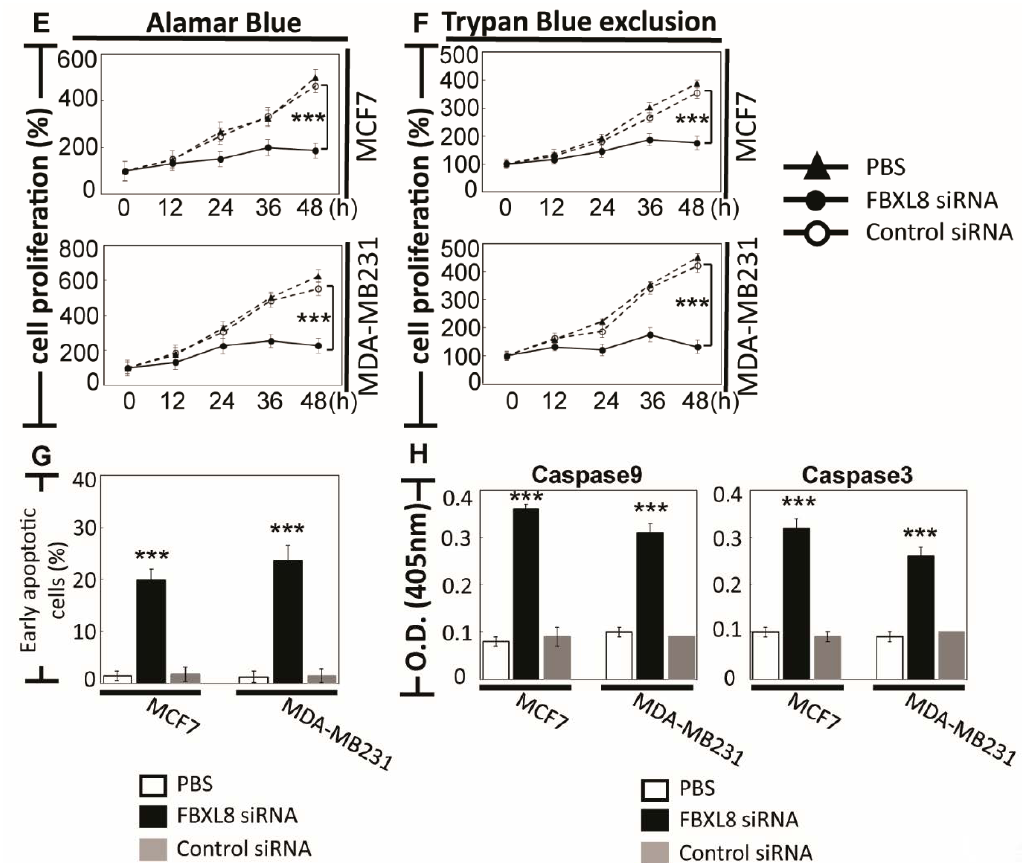
Figure 3. FBXL8 plays a critical anti-apoptotic role in BRCA. To elucidate the functional role of FBXL8 in breast carcinoma, we analyzed various human breast cancer cell lines: MCF-7 and MDA-MB231, compared to a non-cancer control breast cell line, MCF10A. ( A ) qRT-PCR shows the endogenous levels of FBXL8 mRNA in MCF7 and MDA-MB231, compared to MCF10A cells. FBXL8 mRNA is significantly upregulated in breast carcinoma cells. ( B ) qRT-PCR analysis was used to measure the RNAi e ffi cacy. Optimized transfection e ffi cacy with FBXL8-specific siRNA is shown in both MCF7 and MBA-MD231 cells. Knockdown e ffi ciency was optimal at 24 h where, up to 95% loss of FBXL8 mRNA was achieved in both cell lines, compared to controls using PBS (phosphate bu ff ered saline) and scrambled siRNA (***, p < 0.001). The cell viability of FBXL8 knocked down BRCA cell lines was significantly reduced as shown by: ( C ) MTT and ( D ) CTB assays. For each time point, cell counts were normalized to the corresponding PBS-treated controls. ( E ) Alamar Blue or ( F ) Trypan Blue exclusion tests showed significant reduction in cell proliferation. ( G ) Annexin V and 7-aminoactinomycin (7-AAD) double staining was conducted to examine early apoptosis (AnnexinV + / 7AAD − , red box). ( H ) FBXL8-siRNA knockdown of MCF7 and MDA-MB231 cells underwent apoptosis via activation of Caspases -9 and -3, suggesting that presence of FBXL8 is pivotal to anti-apoptosis in BRCA. Representative histograms of apoptosis assay are shown in Figure S5. Data are means ± SD ( n = 3). ***, p < 0.001.